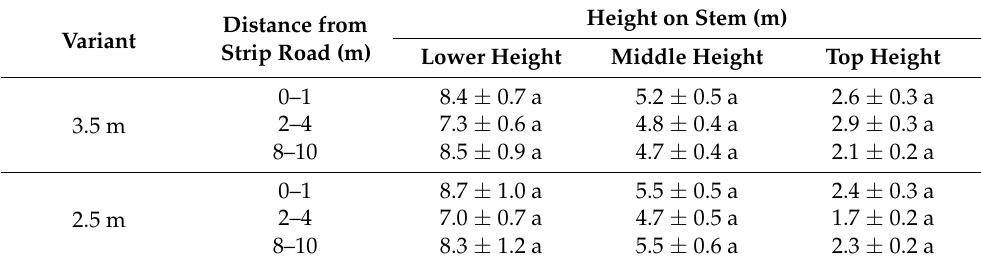
Table 4. Stem pith eccentricity (mm; mean values ± SE) related to the height on the tree and the distance from the strip road. Height on Stem (m) Distance from Variant Strip Road (m) Lower Height Middle Height